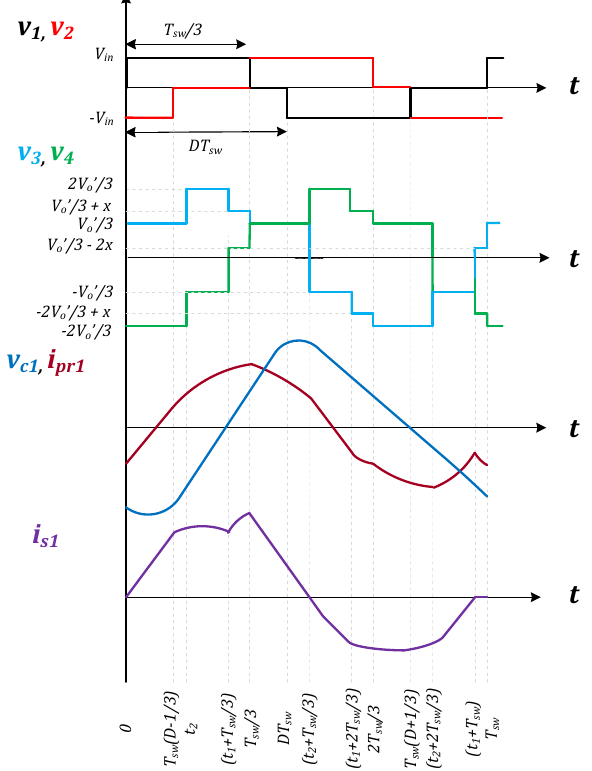
Figure 8. DCM1 mode waveforms.